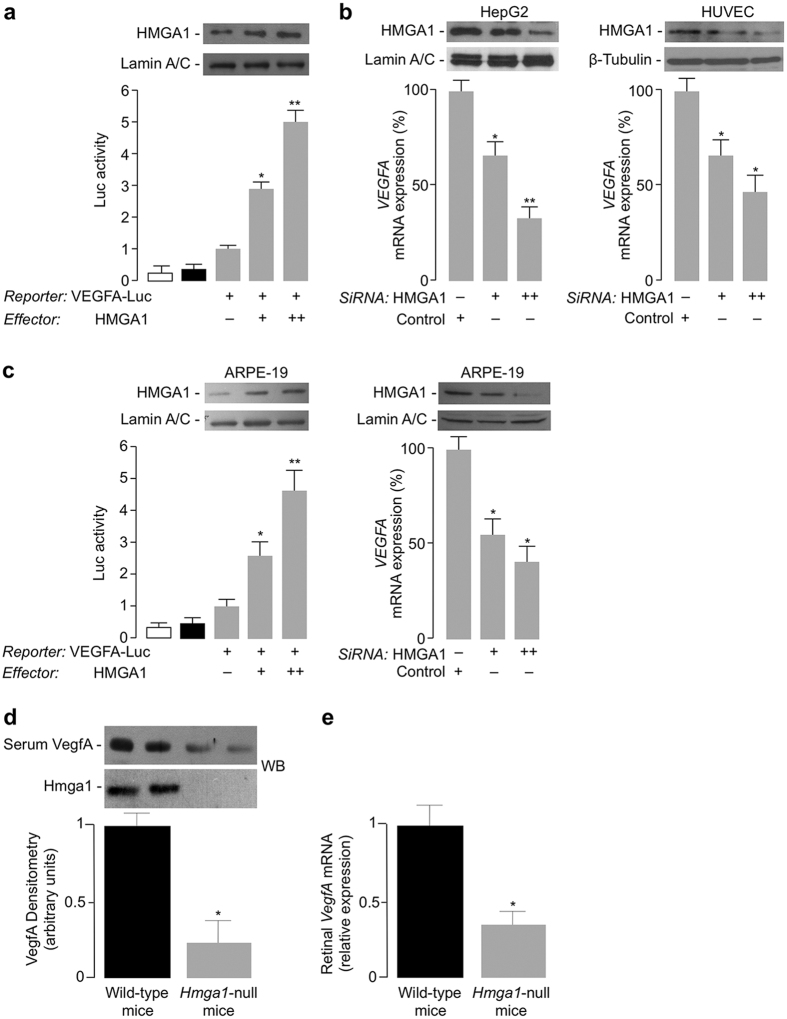
VEGFA gene expression is induced by HMGA1.(a) Human VEGFA-Luc reporter vector (2 μg) was transfected into HepG2 cells, in the presence of increasing amounts (0, 0.5, 1 μg) of HMGA1 effector plasmid, and Luc-activity was measured 48 h later. Data represent means ± s.e.m for three separate experiments; values are expressed as the factors by which Luc-activity increased above the level of the activity obtained in transfections with VEGFA-Luc reporter vector plus the empty effector vector (control), which is assigned an arbitrary value of 1. White bar, mock (no DNA); black bar, pGL3-basic (vector without an insert). *P < 0.05 and **P < 0.01 vs control. (b) qRT-PCR of endogenous VEGFA mRNA from HepG2 (left), and HUVEC (right) cells, pretreated with increasing amounts (100 and 200 pmol) of anti-HMGA1 siRNA or nontargeting control siRNA. (c) VEGFA-Luc-activity and qRT-PCR of endogenous VEGFA mRNA were measured in ARPE-19 cells, under the same conditions as in (a) and (b). WBs of HMGA1 in each condition are shown in the autoradiograms. Lamin A/C and β-Tubulin, controls of protein loading. Cropped blots are shown in the figures. Full-length WBs are presented in Supplementary Fig. S1. *P < 0.05 and **P < 0.001 vs siRNA-untreated (control) cells. (d) Representative VegfA WB of blood serum from wild-type and Hmga1-deficient mice. Densitometric analyses of six to eight independent blots are shown. Black bars, wild-type mice, n = 8; gray bars, Hmga1-knockout mice, n = 6. *P < 0.05 vs wild-type controls. Hmga1 protein expression is shown in fat tissue. All the samples were run under the same experimental conditions. Cropped blots are shown in the figures. Full-length WBs are presented in Supplementary Fig. S1. (e) VegfA mRNA levels in retinal tissue of wild-type (black bars) and Hmga1-deficient (gray bars) mice (n = 6 per genotype), as measured by qRT-PCR. Data are means ± s.e.m of three independent measurements from each animal. *P < 0.05 vs wild-type controls.